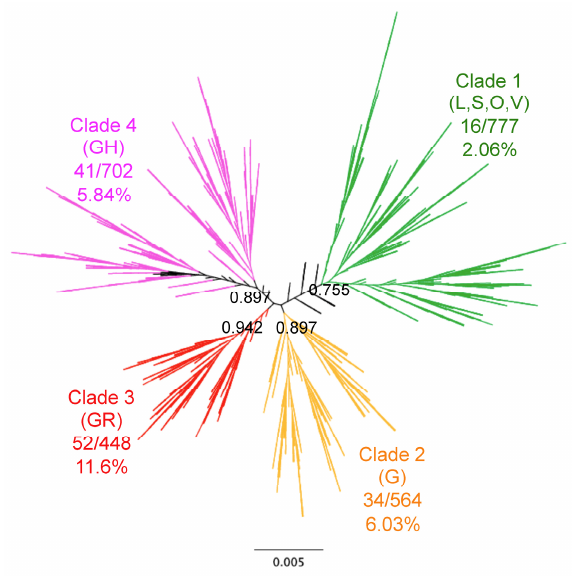
Figure 1. Genomic diversity of SARS-CoV-2 and patient mortality. Phylogenetic analysis of SARS- CoV-2 genomes from 2508 patients. The unrooted tree showed four main Clades (Clades 1–4) with a strong phylogenetic support as specified for each major branch, and mortality rates varied significantly among Clades as indicated (X 2 = 47.93, d.f. =3, p < 0.0001). GISAID clade names are indicated in parenthesis for